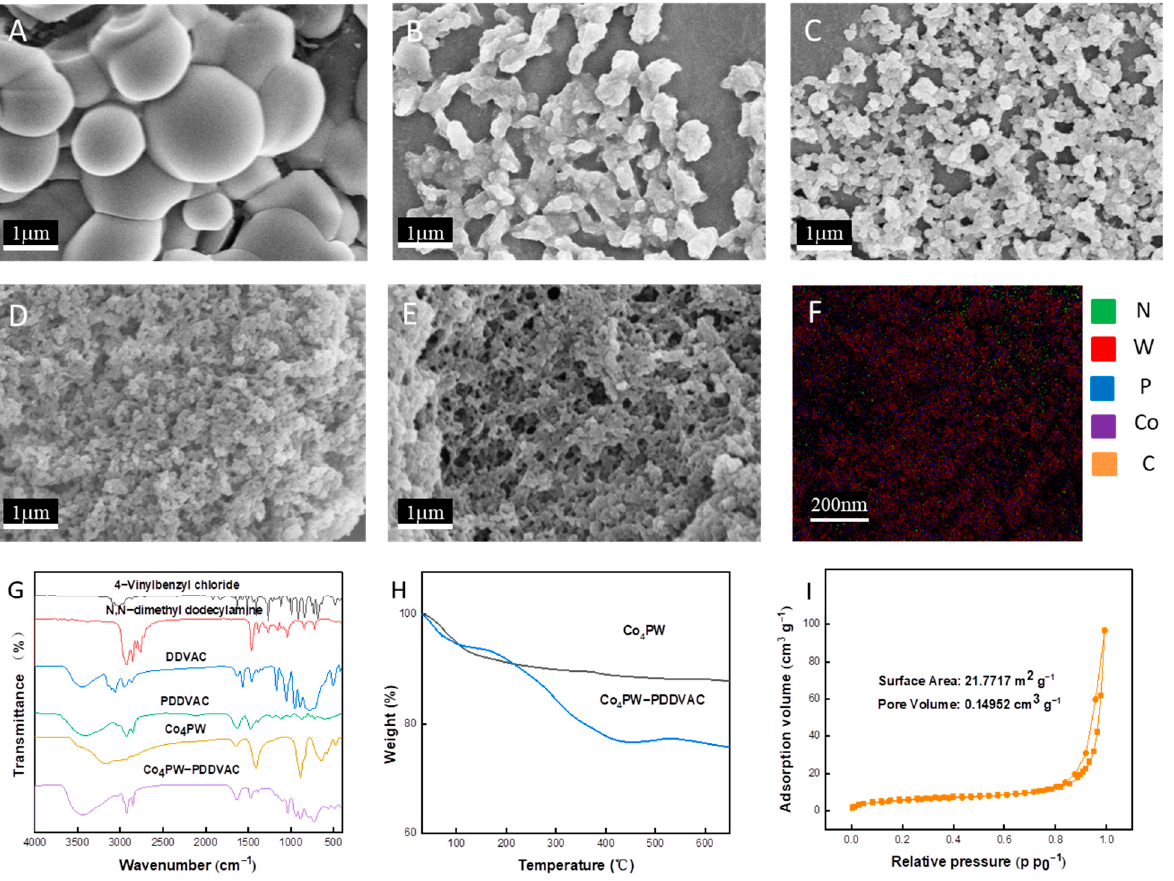
Figure 1. SEM images of Co 4 PW–PDDVAC composites prepared with PDDVAC/Co 4 PW molar ratio of ( A ) 1:1, ( B ) 2:1, ( C ) 5:1, ( D ) 10:1, and ( E ) 15:1. ( F ) EDS mapping of Co 4 PW–PDDVAC